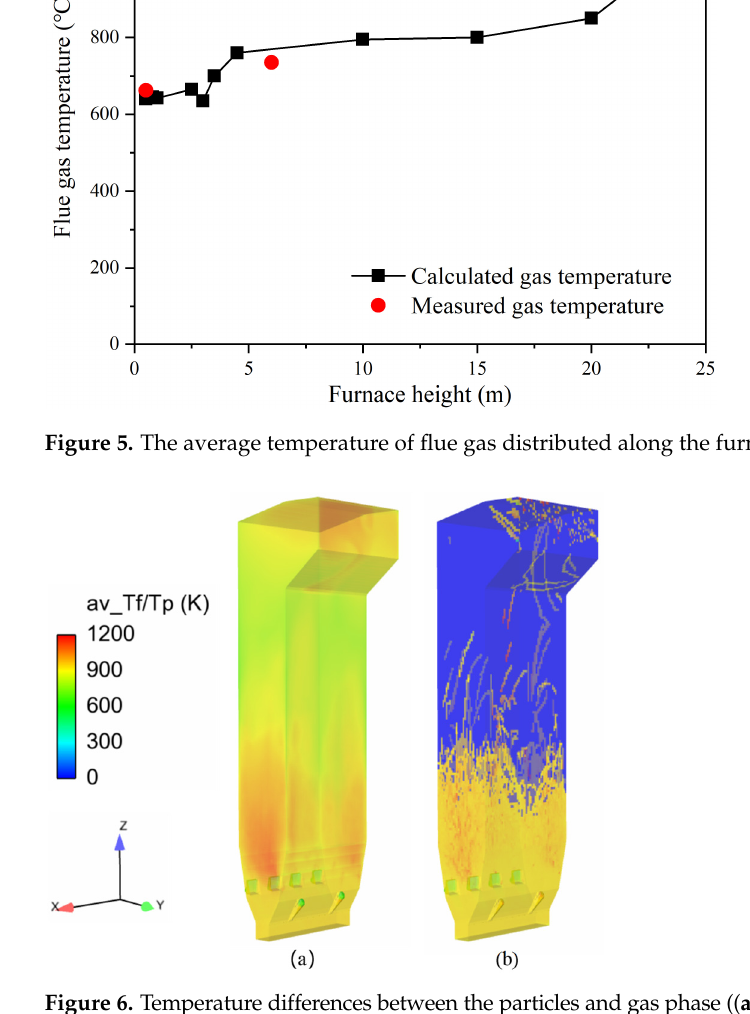
Figure 5. The average temperature of flue gas distributed along the furnace height in Case 1.